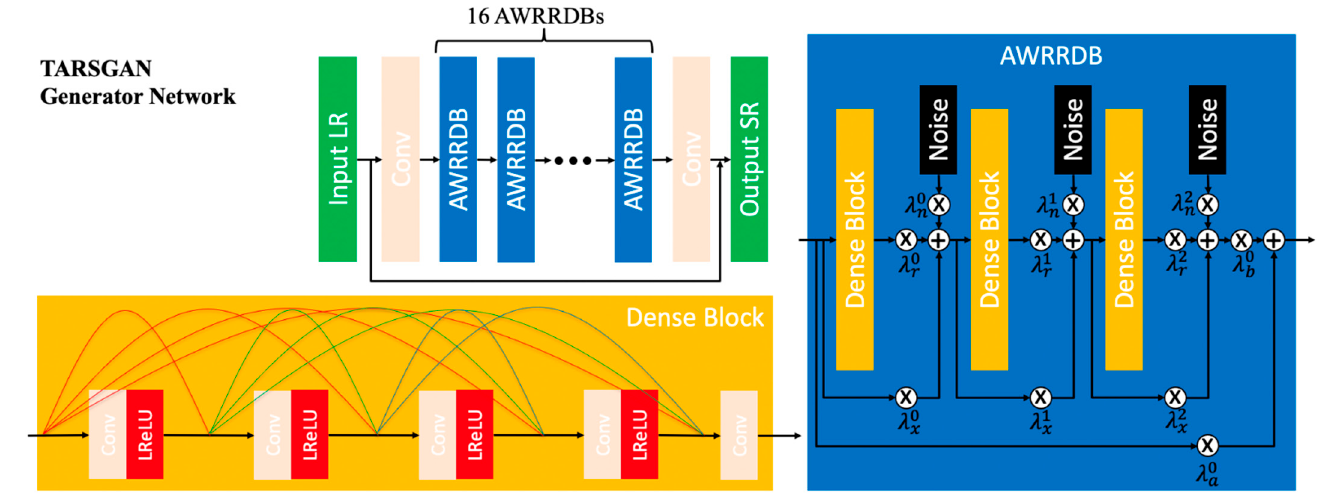
Figure 3. Network architecture of the TARSGAN generator.